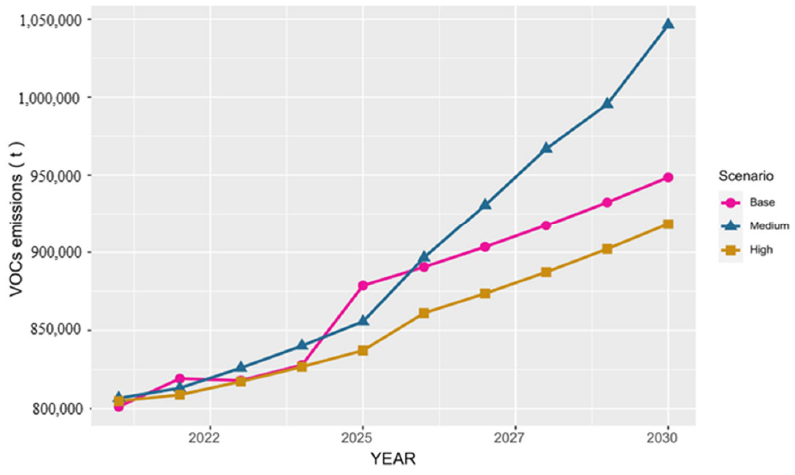
Figure 4. Projected emissions of VOCs from buildings in China, 2020–2030.